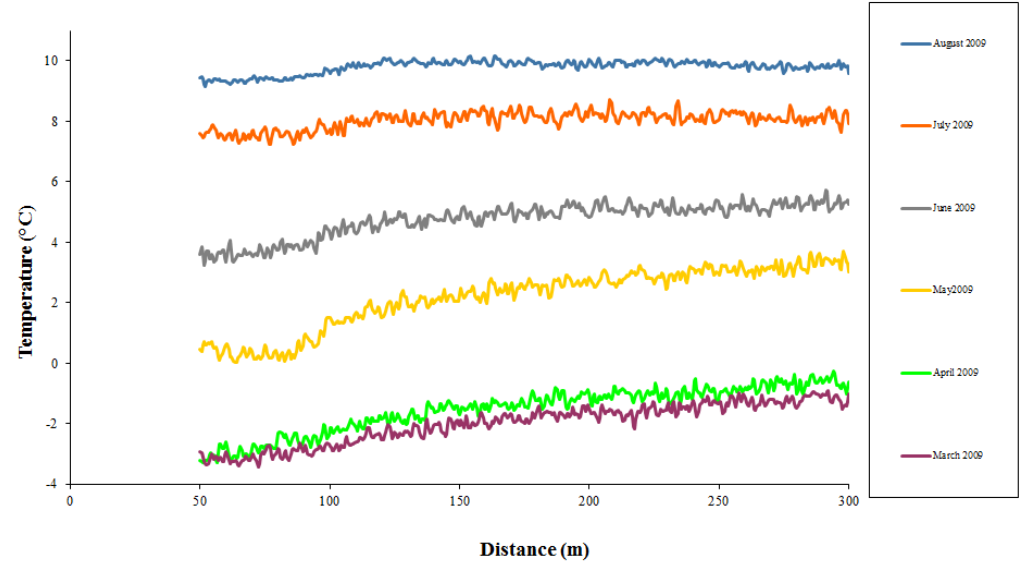
Figure 4. Seabed sediment temperatures measured from March 2009 to August 2009 in Liito-oravankatu. The Sun is obviously loading the heat to the seabed sediment.